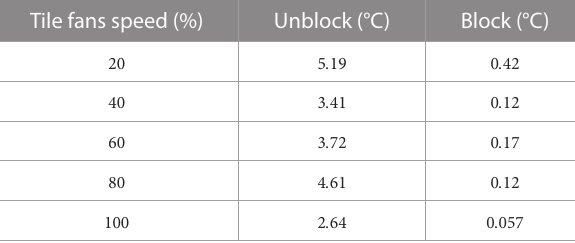
TABLE2 TVsforbothblockedandunblockedunder-rackgapsatvarious tilefansspeed.